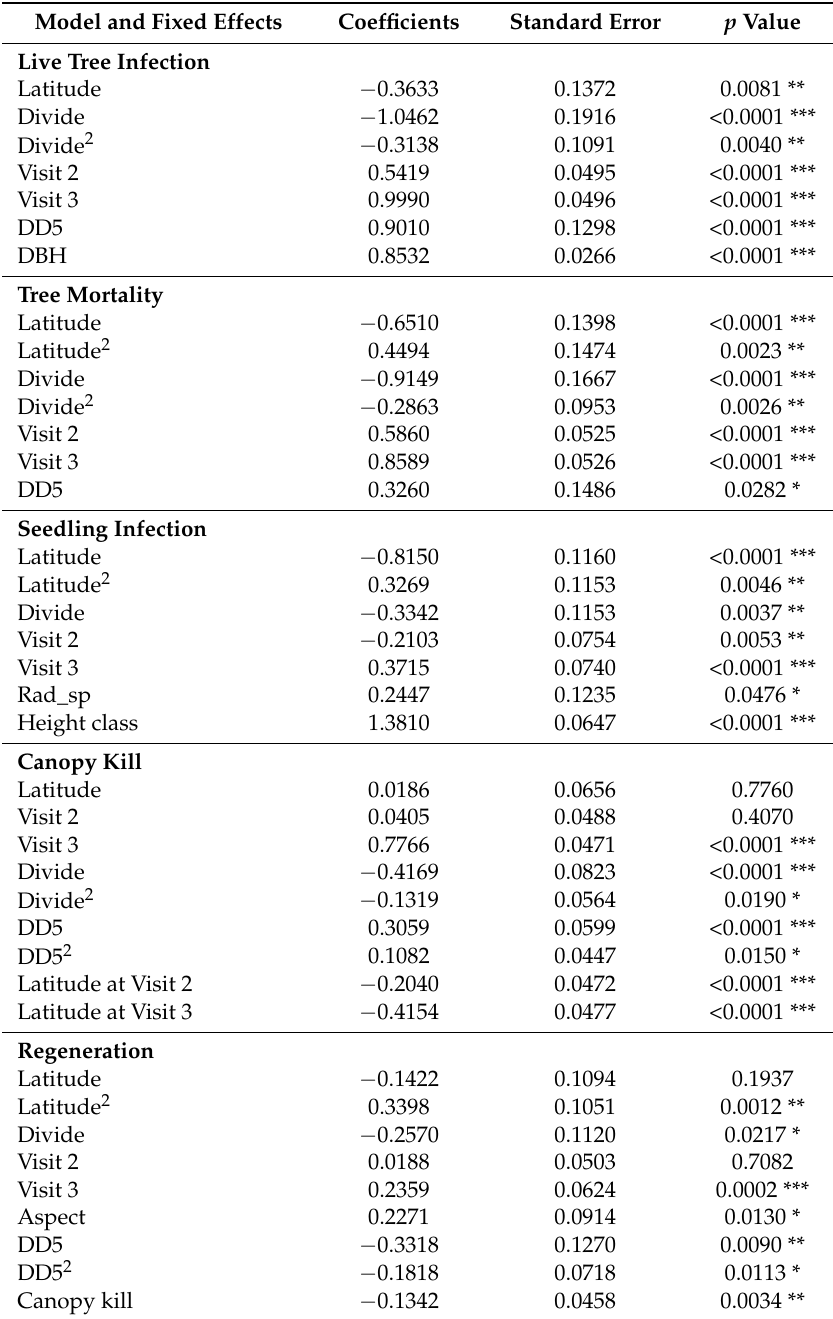
Table 2. Summary of final generalized linear mixed models predicting live tree infection, tree mortality, seedling infection, canopy kill, and regeneration. All continuous variables were standardized prior to analysis. Table 1 describes all predictor and response